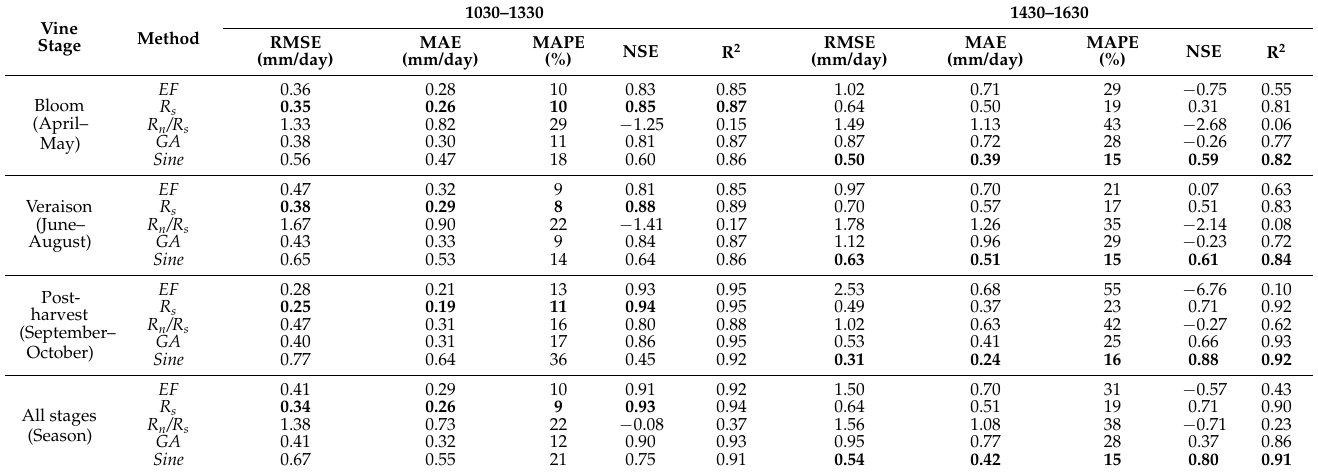
Table 3. Goodness-of-fit statistics of daily ET extrapolation methods at two different time windows (1030–1330 and 1430–1630 PST) using only EC tower information in